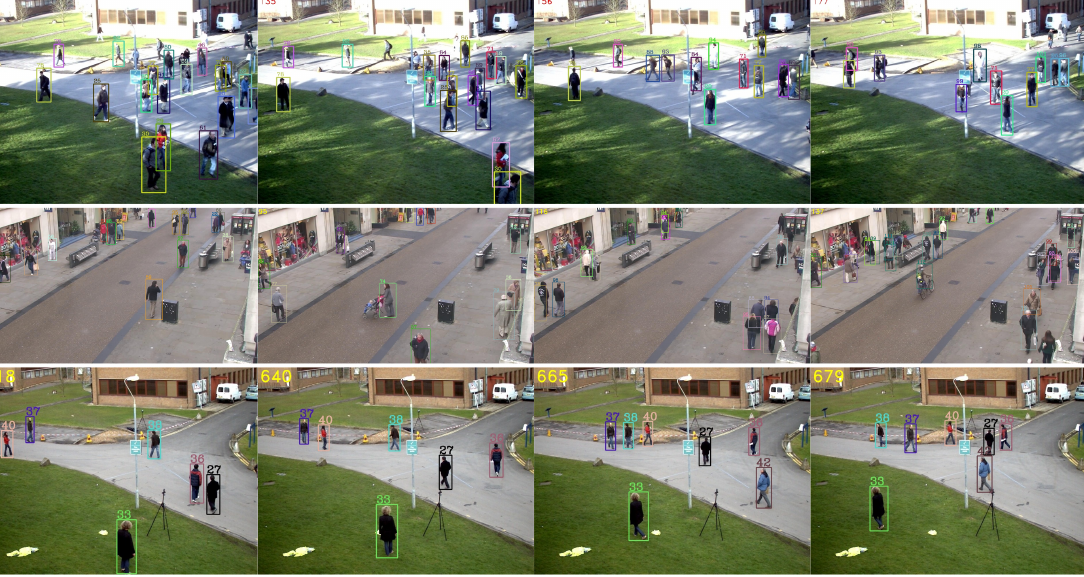
Figure 8. Tracking result on 2DMOT15